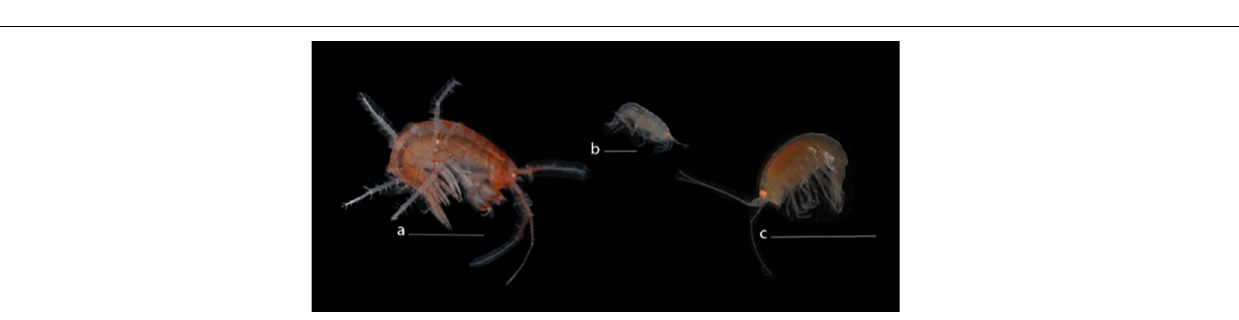
FIGURE 8 | Total individuals described to family level for Amphipoda during biological sampling of hydrothermally and non-hydrothermally influenced sites using ROV Phoca.